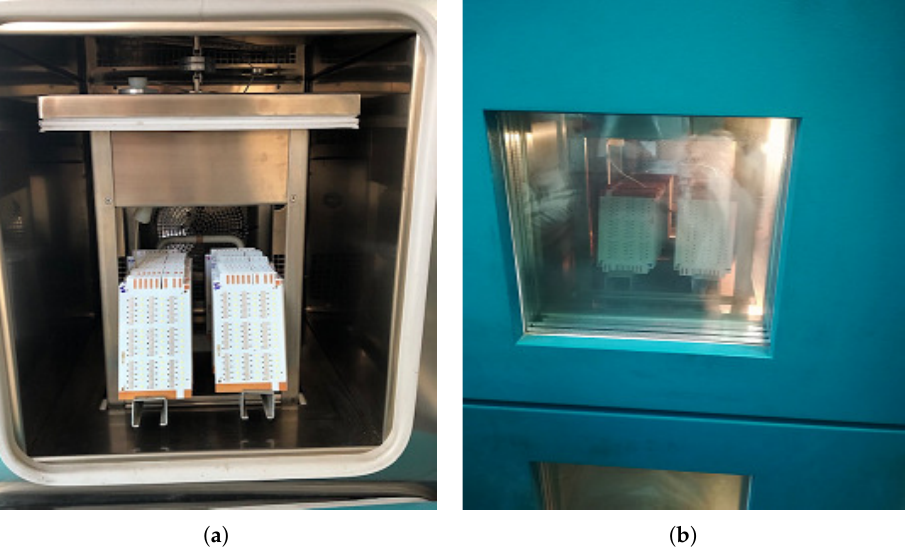
Figure 2. ( a ) Circuits positioned in the climatic chamber CST 27/2T of Angelantoni test technologies. ( b ) A mechanical transfer carriage moves circuits from one chamber to another.